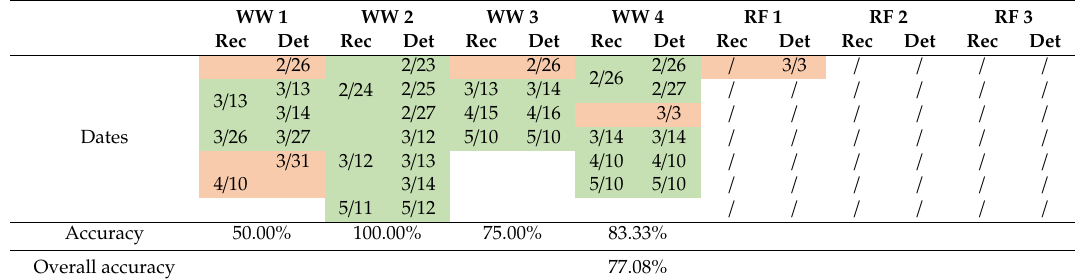
Table 2. Overall accuracy of the irrigation timing detection results.